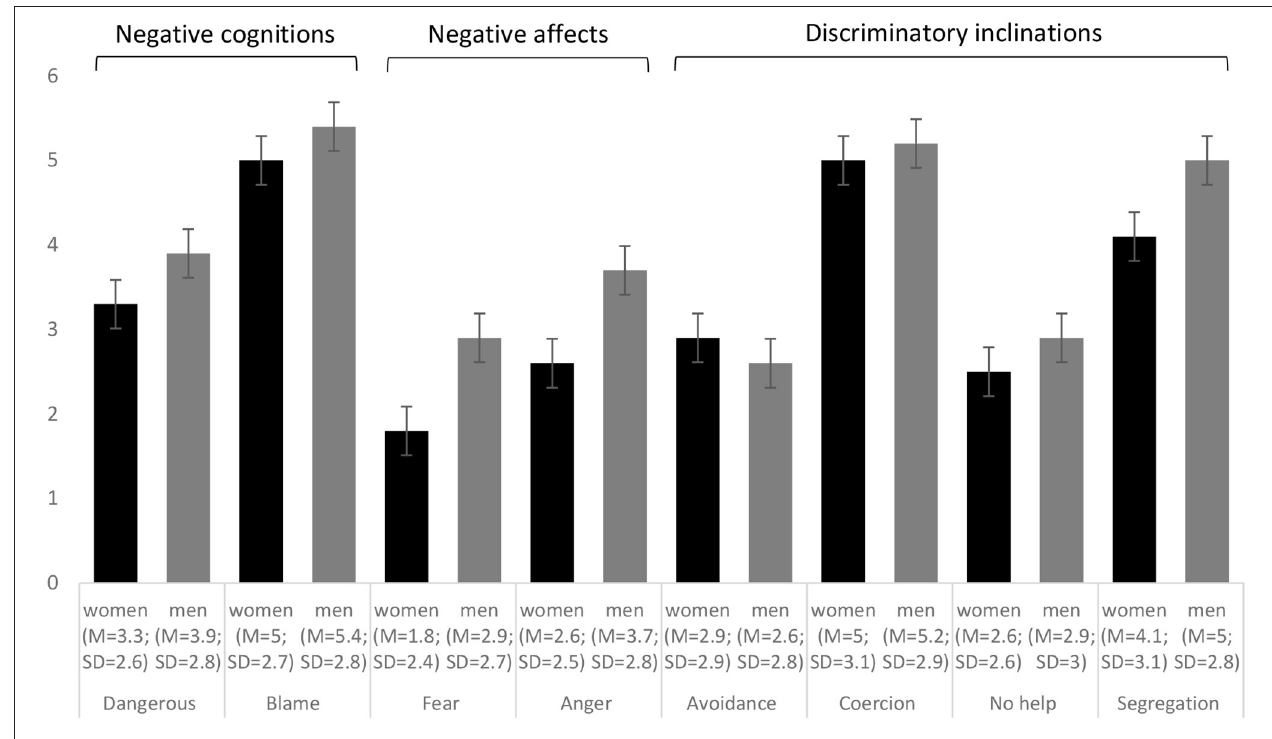
FIGURE 1 | Means ( M ) and standard deviations ( SD , error bars) of the attribution questionnaire (AQ † ) for the sample of women (black bars) and men (gray bars), with imputed data ( Number of imputations = 20; Number of observations = 320 per sample). † Dangerous: I think she/he ‡ is dangerous. Blame: I would think that it was her/his ‡ own fault that she/he ‡ is in the present condition. Fear: I would feel scared of her/him ‡ . Anger: I would feel angry at her/him ‡ . Avoidance: I would try to stay away from her/him ‡ . Coercion: Her/His ‡ doctor should force him/her ‡ into treatment, even if she/he ‡ does not want to. No help: I would probably help her/him